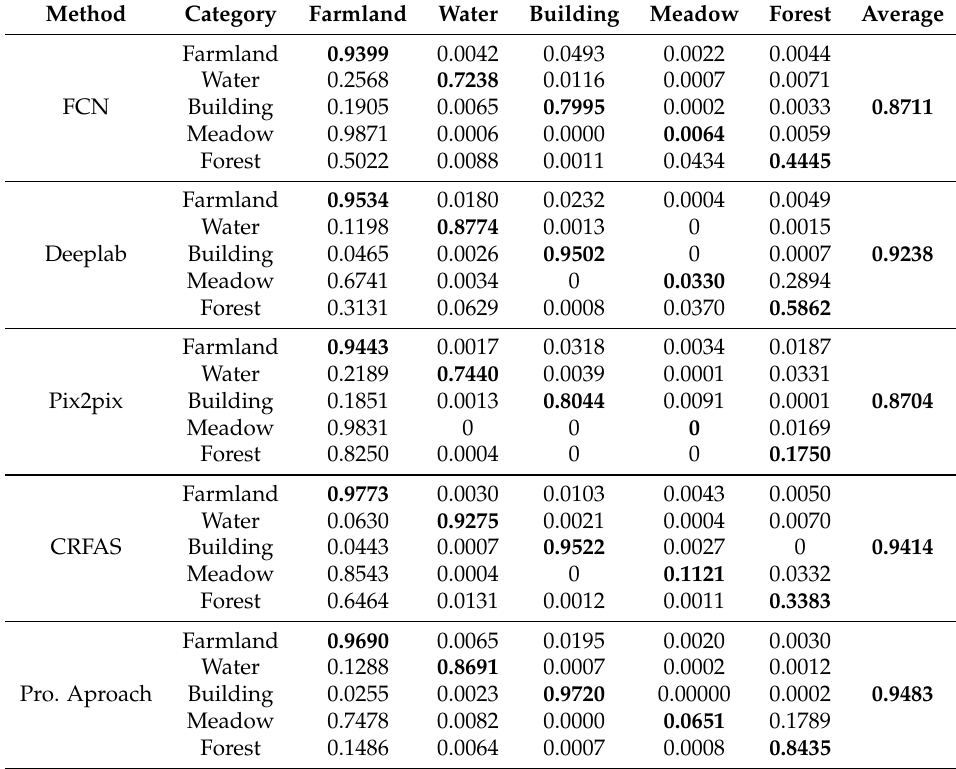
Table 5. Confusion matrix for